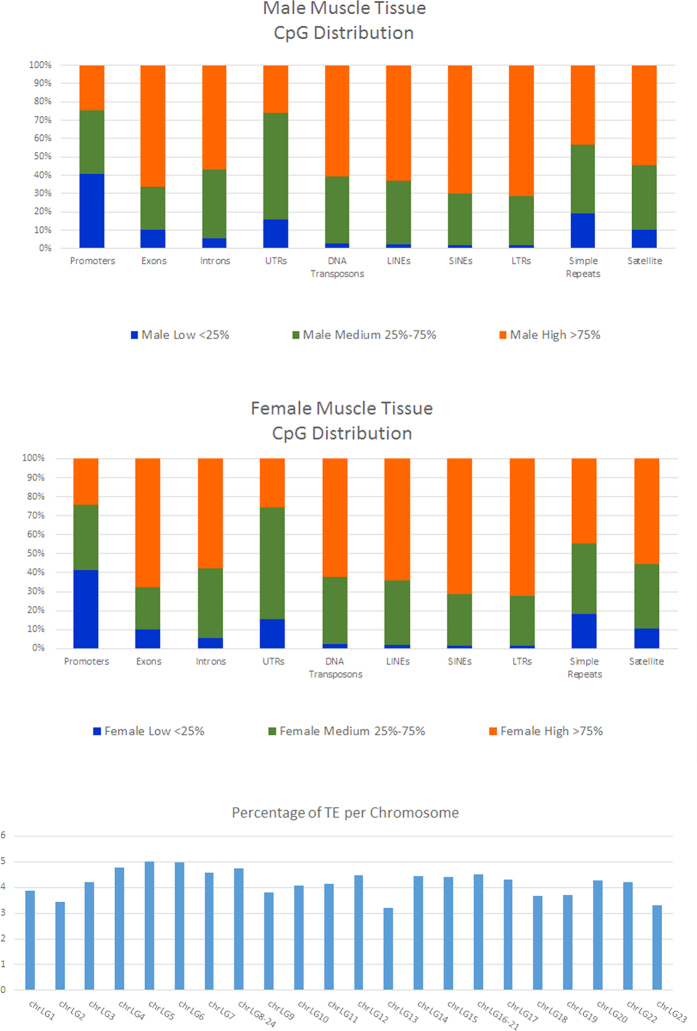
Numbers of hypermethylated DMRs in male (blue) and female (red) tilapia skeletal muscle tissue.Dotted line graph represents the Z-score of number of DMRs in each chromosome. In this plot, chromosome LG1 shows very high number of DMRs as compared to the other chromosomes (Z-score > 3).